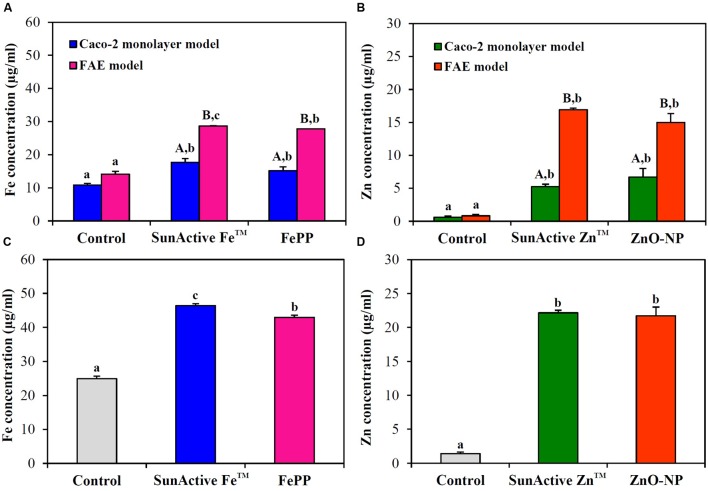
Intestinal transport mechanism of
(A) SunActive FeTM and (B) SunActive ZnTM evaluated using in vitro models of Caco-2 monolayers and human FAE after treatment for 6 h. Combined total intestinal transport amount of (C) SunActive FeTM and (D) SunActive ZnTM through both Caco-2 monolayers and the FAE model. FePP and ZnO-NPs were used as counterpart materials for SunActive FeTM and SunActive ZnTM, respectively. Mean values with different letters in minuscule (a,b,c) in the same figure indicate significant differences among untreated control, SunActiveTM product, and its counterpart material (p < 0.05). Mean values with different letters in majuscule (A,B) in the same figure indicate significant differences between Caco-2 monolayers and the FAE model (p < 0.05).